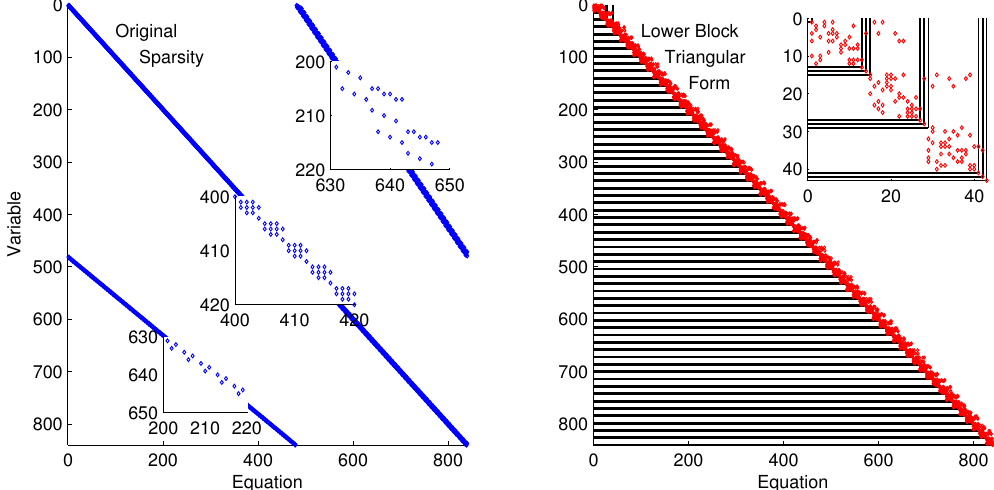
Figure 9. Lower block triangular form with blocks of variables and equations that are solved successively and